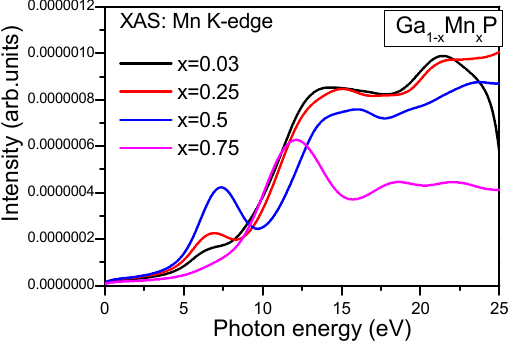
Figure 8. K edge X-ray absorption spectrum of Mn in Ga 1 − x Mn x P alloys at different concentrations of x = 0.03, 0.25, 0.5, and 0.75 within the GGA + U approach.